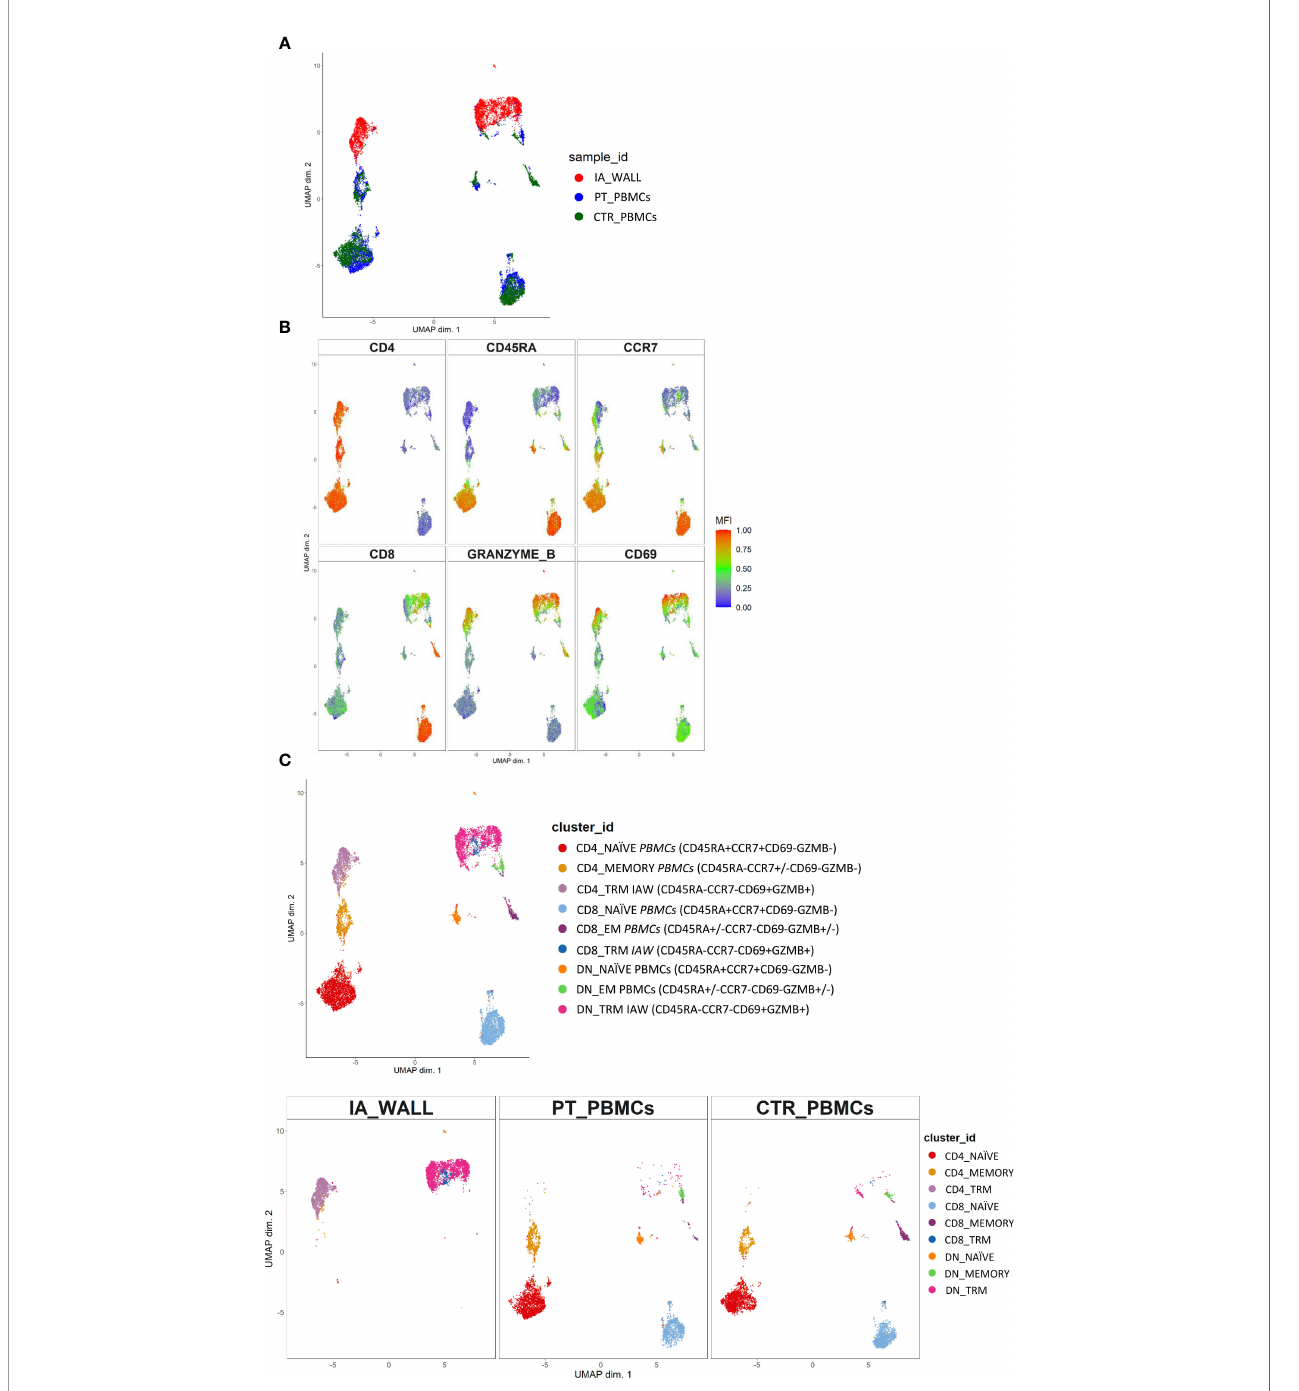
FIGURE 2 | Unsupervised ex vivo fl ow cytometric analysis reveals unique T-cell clusters in the IA wall. (A) UMAP projections of normalized expression of markers colored according to the analysed sample. Red: T-cells from the IA wall (IA_WALL), blue: T-cells from peripheral blood of the same patient (PT_PBMCs), green: T-cells from peripheral blood of a pediatric control (CTR_PBMCs). (B) Two-dimensional illustration of CD4, CD8, CD45RA, CCR7, GRANZYME B and CD69 expression by UMAP. Blue denotes low, green intermediate and red high expression. (C) Nine different T-cell clusters, i.e. three CD4+, three CD8+ and three DN clusters, were identi fi ed by UMAP and colored according to cell phenotypes as indicated. CCR7, CD45RA, CD69 and GZMB expression identi fi ed three naïve (CCR7+CD45RA+CD69-GZMB-), one memory (CCR7+/-CD45RA-CD69-GZMB-) and two effector memory clusters ( “ EM ” , CCR7-CD45RA+/-CD69-GZMB+/-) in peripheral blood. In addition, three CD69 +GZMB+ clusters were identi fi ed in the IA wall ( “ TRM ” ). Upper panel: overlay of the 3 samples. Lower panels: UMAP Plots strati fi ed according to sample origin: “ IA_WALL ” (left), “ PT_PBMCs ” (middle) and “ CTR_PBMCs ”